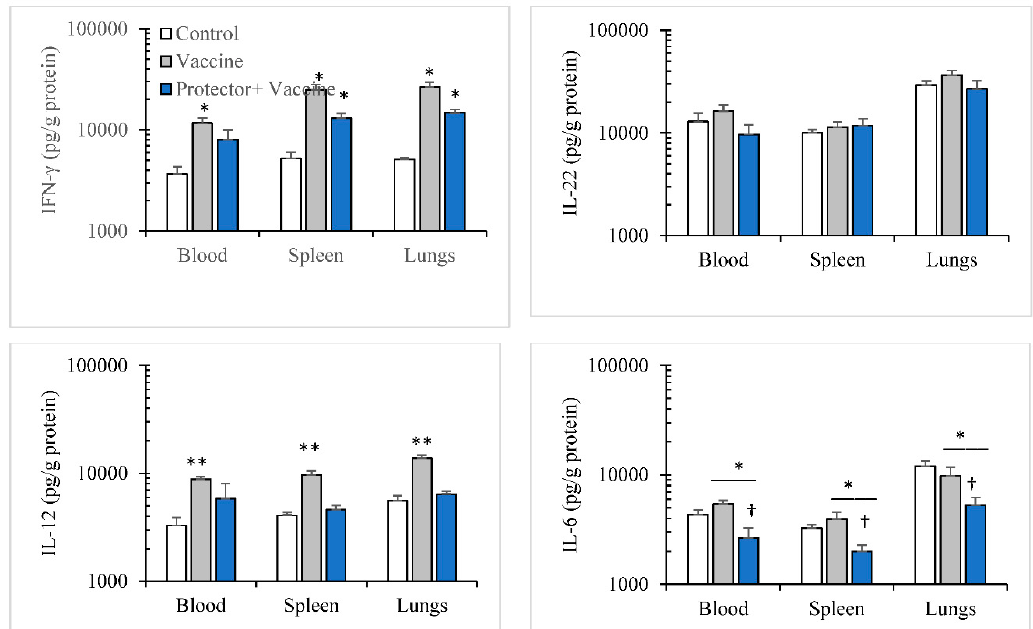
Figure 6. A secondary immunization with Vaxigrip (5 µg/injection at day 1 and 14) enhanced the production of IFN- γ in blood as well as IL-12 in blood, spleen and lungs. When “Protector” (375 µg × 3/day) was orally administered for 2 weeks (one week apart), it modulated Vaxgrip effect on the production of IFN- γ in blood; IL-12 in blood, spleen and lungs; and reduced (†) IL-6 in blood, spleen and lungs. * p < 0.05, ** p < 0.01 in comparison to the control group and the bar represents the significance between the adjacent treatments.